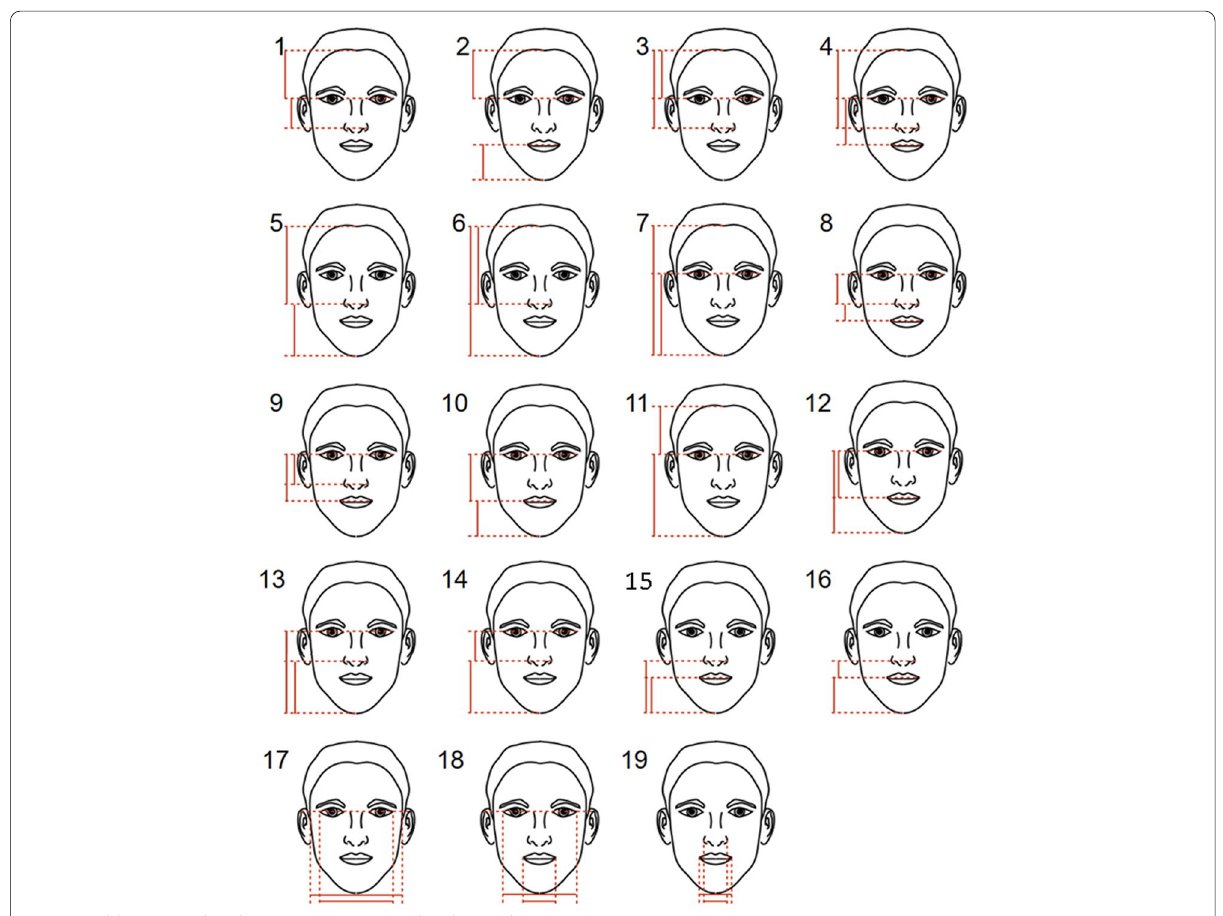
Fig. 3 Golden ratio-related parameters measured in this